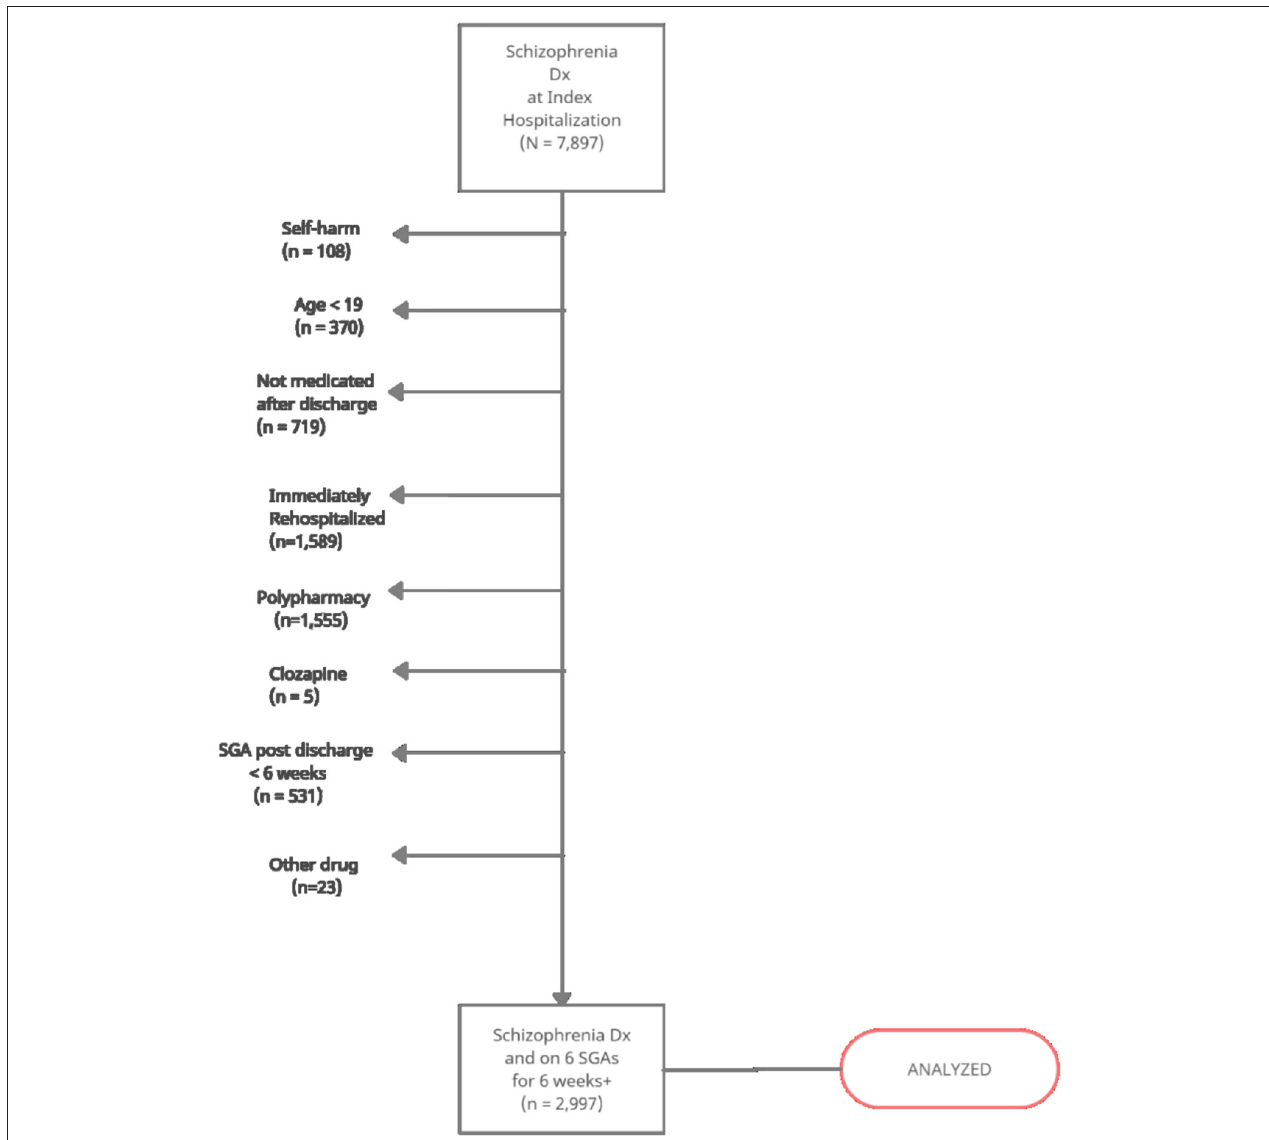
FIGURE 1 | Strobe diagram of a cohort of schizophrenia patients and selection